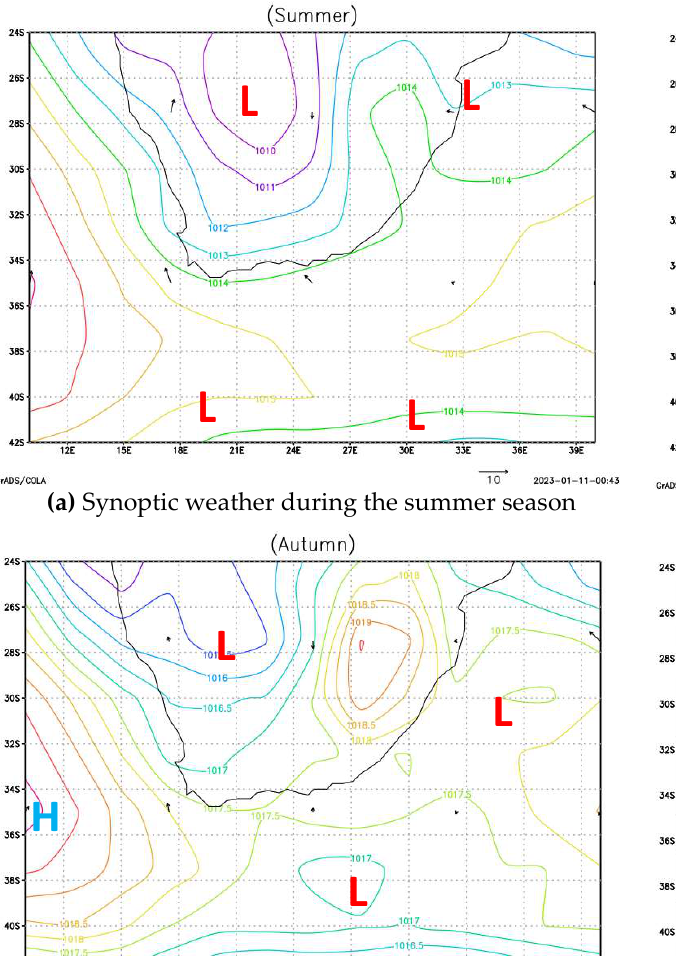
Figure 7. Seasonal ground observation meteorological weather conditions observed at Secunda.